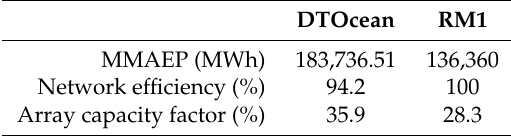
Table 7. Comparison of 50 TEC energy production and